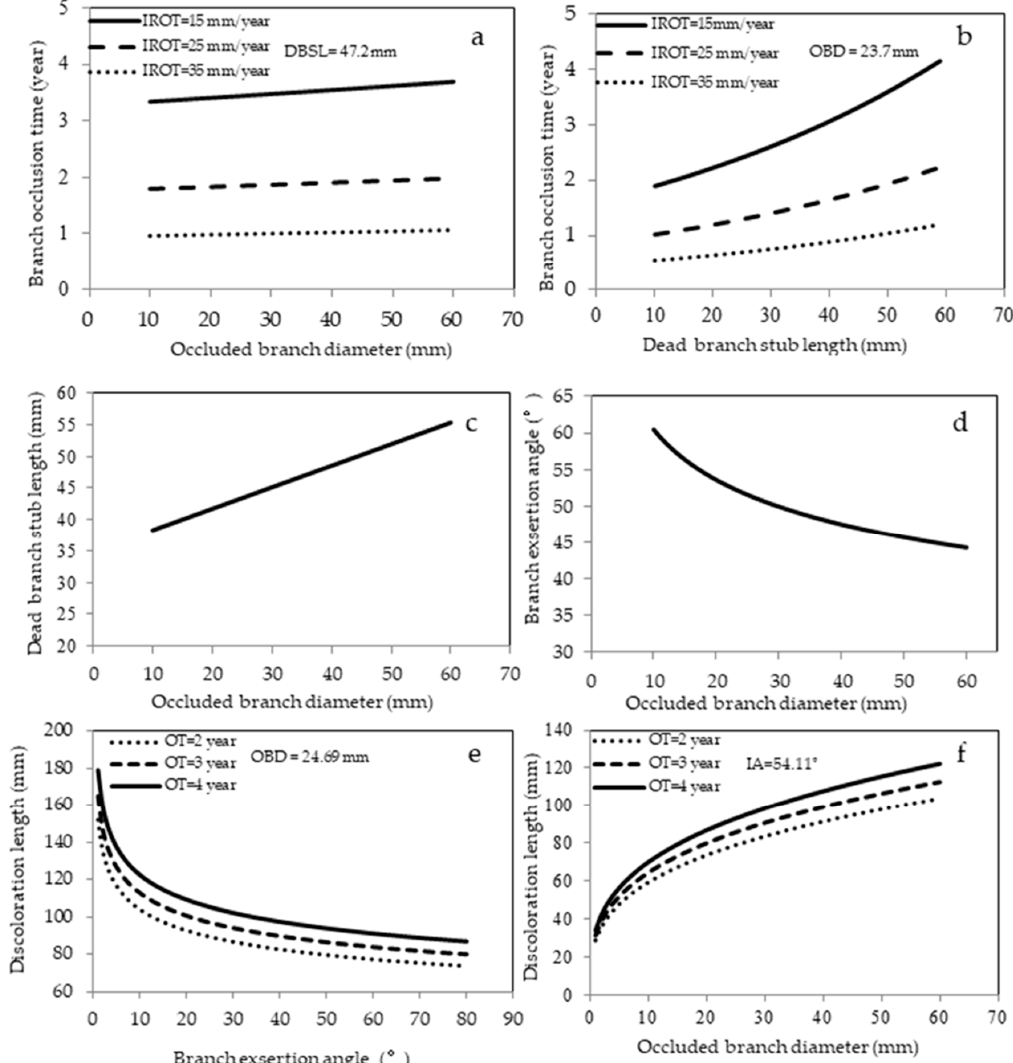
Figure 6. Simulation curves based on marginal models for predicting the branch occlusion time ( a , b ), dead branch stub length ( c ), branch exsertion angle ( d ), and discoloration length ( e , f ). ( a ) Predicted branch occlusion time under natural pruning from the mean dead branch stub length of the whole dataset and di ff erent levels of mean stem radial increment during branch occlusion against the occluded branch diameter. ( b ) Predicted branch occlusion time from the mean occluded branch diameter and di ff erent levels of mean stem radial increment during branch occlusion against the dead branch stub length. ( c ) Predicted dead branch stub length against the occluded branch diameter. ( d ) Predicted branch exsertion angle against the occluded branch diameter. ( e ) Predicted discoloration length from the mean occluded branch diameter and di ff erent levels of branch occlusion time against the branch exsertion angle. ( f ) Predicted discoloration length from the mean branch exsertion angle and di ff erent levels of branch occlusion time against the occluded branch